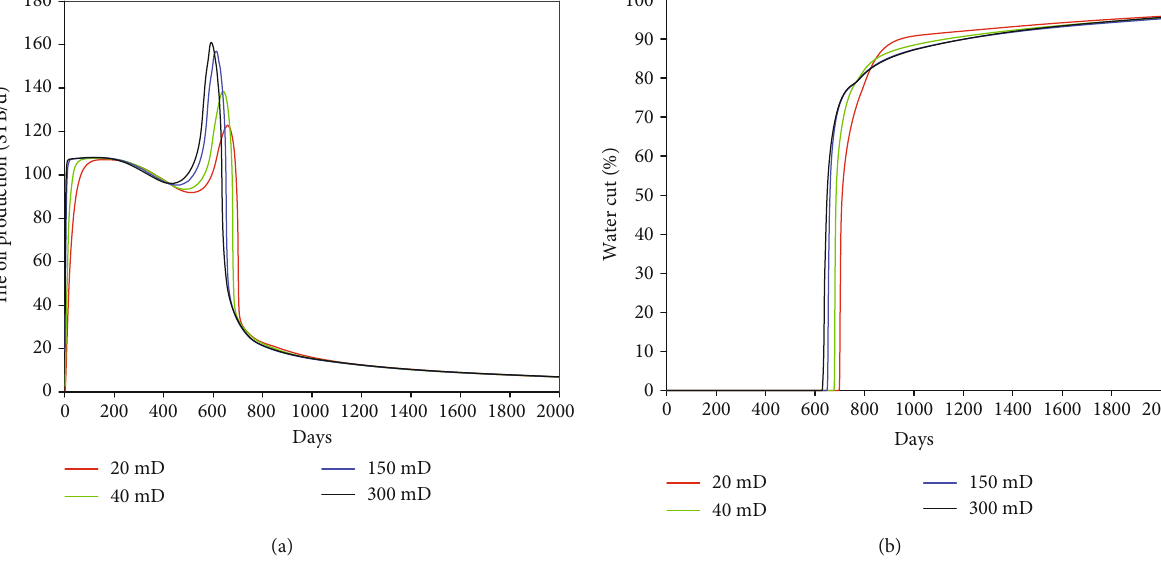
Figure 5: (a) Curves of oil production and water cut with permeability of 20md, 40md, 150 md, and 300md and interlayer angle of 30; (b) the water cut curve a ff ected by the same interlayer angle under di ff erent permeability. Table 1: Model input